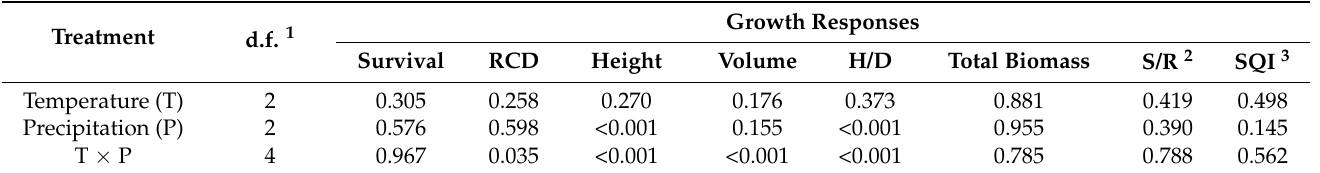
Table 1. Statistical significance ( p -values) of the two-way ANOVA of the effects of experimental extreme climate events on the measured